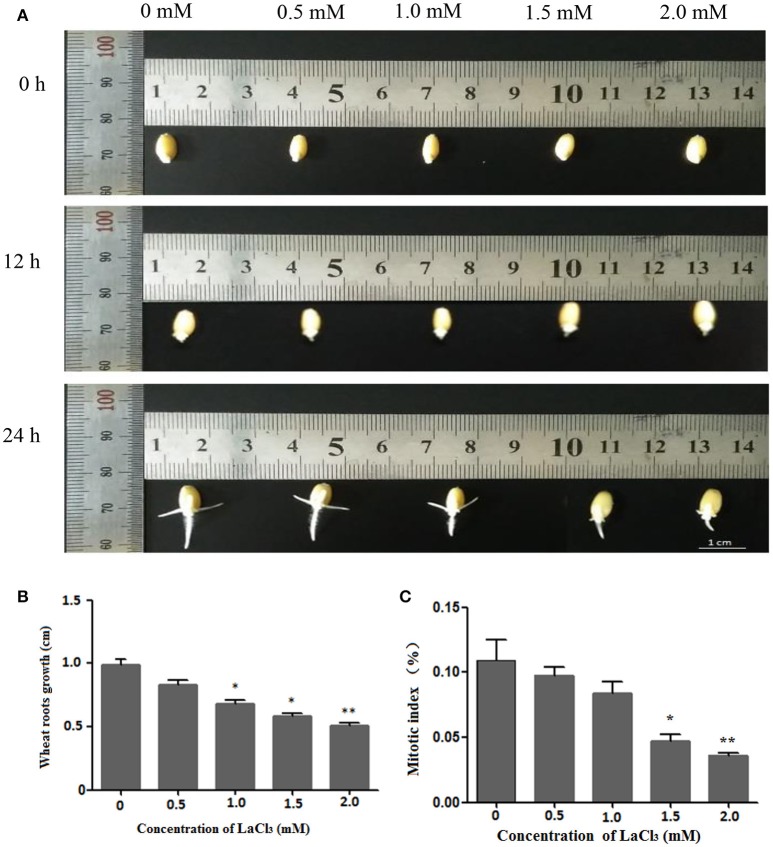
Wheat root length and mitotic index under different concentrations of LaCl3 (0 mM: New Hoagland solution; 0.5 mM: New Hoagland solution +0.5 mM LaCl3; 1.0 mM: New Hoagland solution +1.0 mM LaCl3; 1.5 mM: New Hoagland solution +1.5 mM LaCl3; 2.0 mM: New Hoagland solution +2.0 mM LaCl3). The experiments and statistical analyses were performed in three biological replicates. *Significant difference (p < 0.05); **Highly significant difference (p < 0.01). (A) Micrograph showing grown roots of germinated seeds in different groups at 0, 12, 24 h. (B) A bar chart showing the statistical results of the root length at 24 h. (C) A chart showing the statistical results of the mitotic index of wheat roots at 24 h. Scale bar = 1.0 cm.